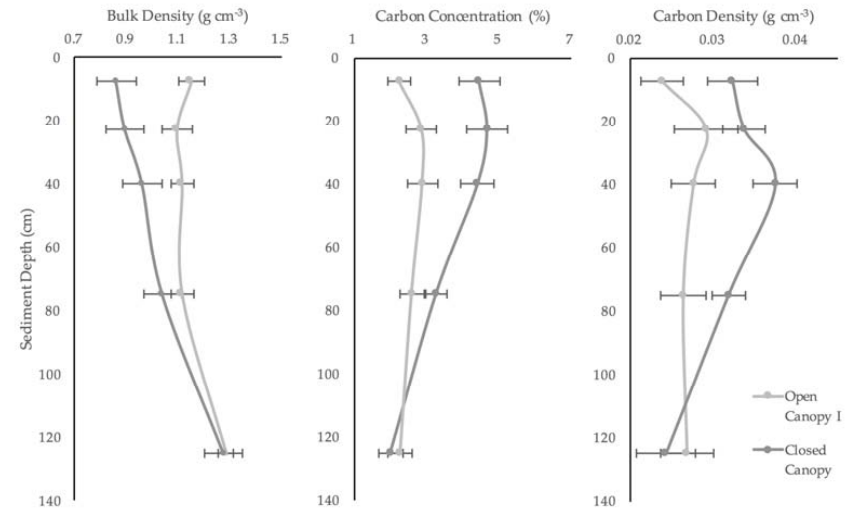
Figure 6. Mean soil bulk density, C concentration, and C density with depth for open ‐ and closed ‐ canopy mangroves; error bars represent ±1 standard error.